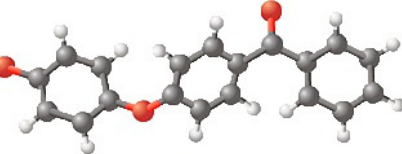
Figure 1. The polyetheretherketone (PEEK) structure.